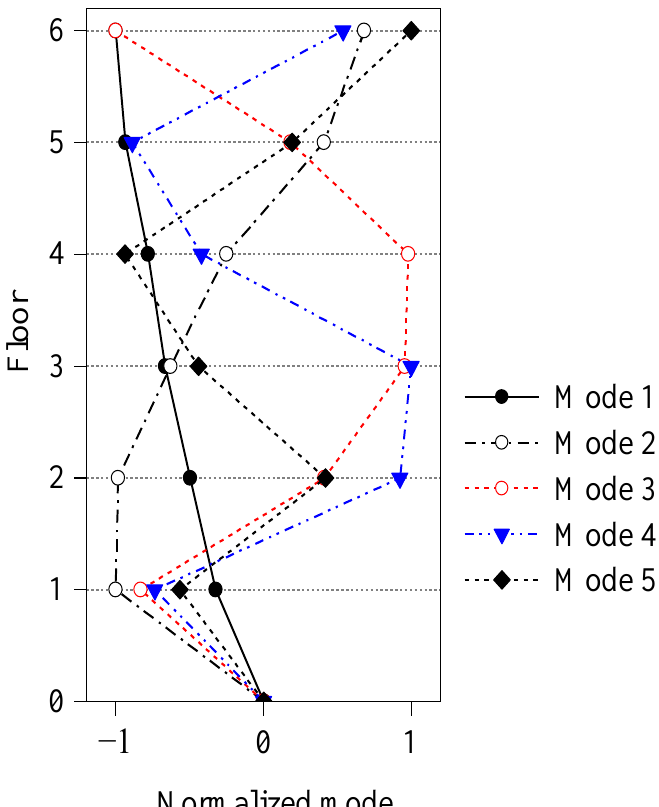
Figure 7. Mode shapes of the isolated structure.